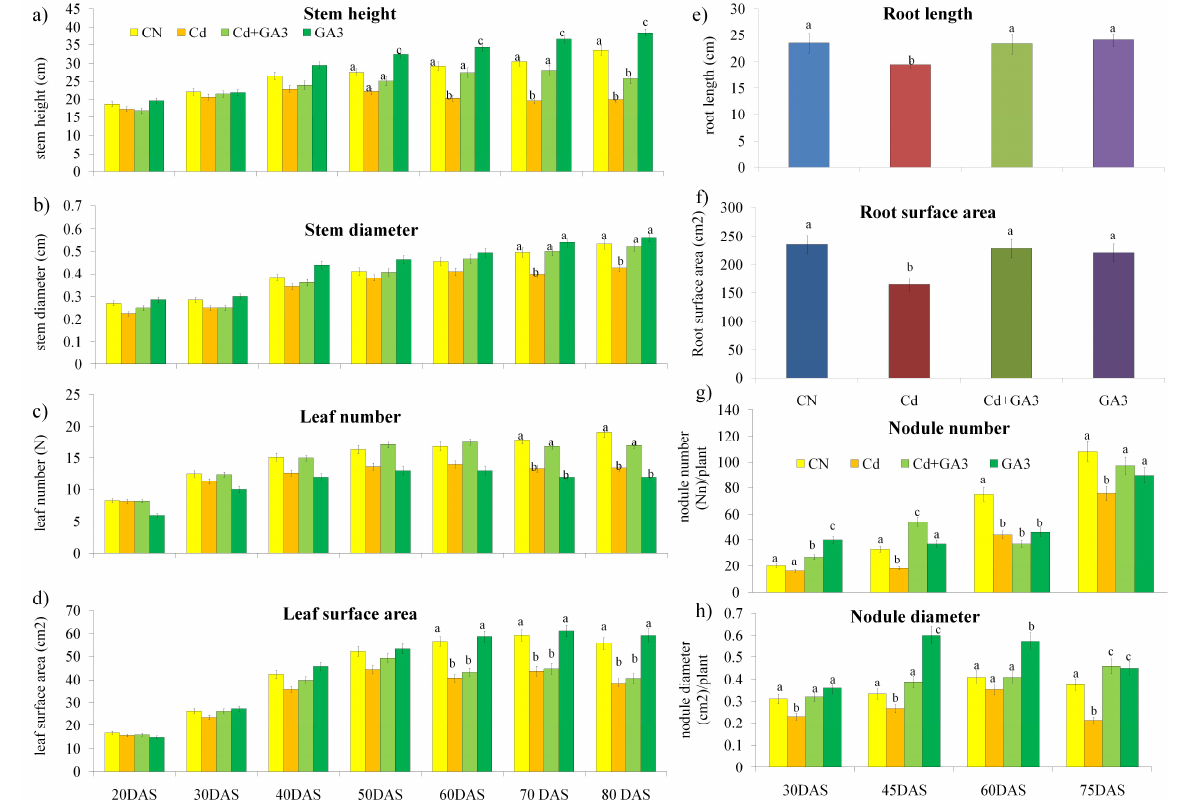
Figure 2. Effect of GA 3 on the growth parameters of mung bean plants under cadmium (Cd) stress in soil. Effect of GA 3 with or without cadmium (Cd) stress on stem height (cm) ( a ), stem diameter (cm) ( b ), leaf number ( N ) ( c ), leaf surface area (cm 2 ) ( d ), root length (cm) ( e ), root surface area (cm 2 ) ( f ), nodule number ( g ), nodule diameter (cm) ( h ) of mung bean plants grown in soil in pots at 20 days after sowing (DAS), 30 DAS, 40 DAS, 50 DAS, 60 DAS, 70 DAS, and 80 DAS for ( a – d ) and 30 DAS, 45 DAS, 60 DAS, and 75 DAS for ( e – h ) grown under control (CN), cadmium (Cd) stress, Cd+ gibberellins (GA 3 ), and GA 3 alone conditions. Data presented are means ± standard errors ( n = 10, biological replicates). Different letters (a, b, c) indicate significant differences from control in all combinations (Tukey’s test, p ≤ 0.05).